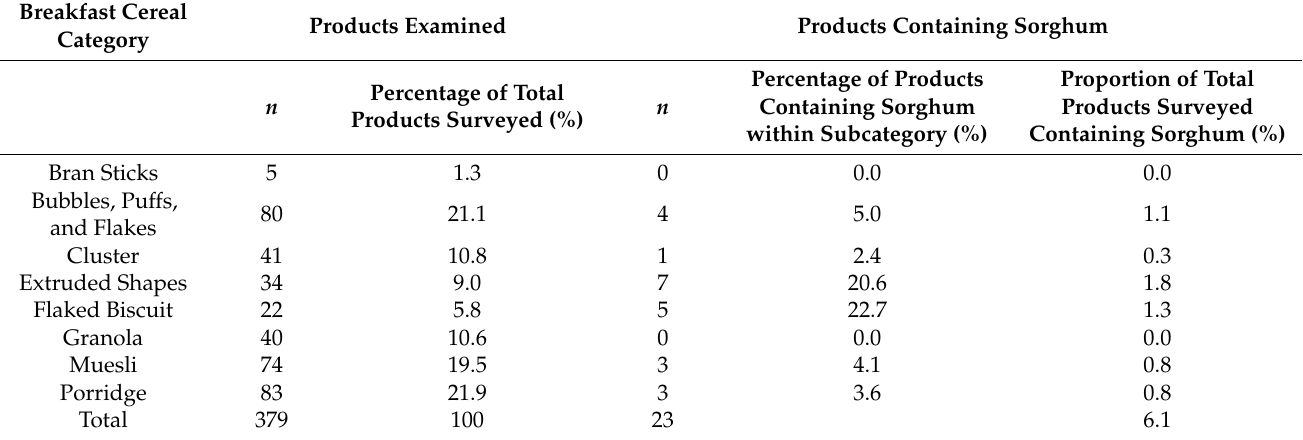
Table 1. Prevalence of sorghum ingredients in breakfast cereals surveyed in the supermarket